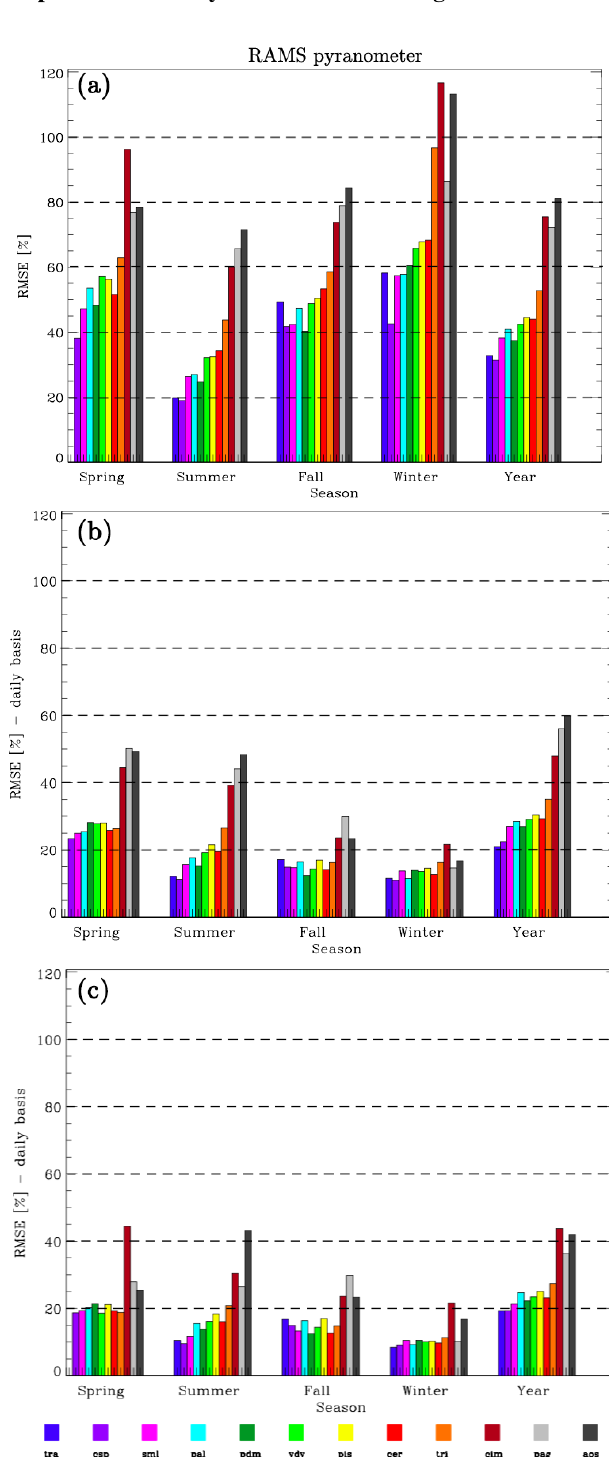
Figure 7. (a) rRMSE computed for different seasons and stations, as well as for the whole year, for the RAMS-GHI 1-day hourly fore- cast; (b) as in (a) for daily integrated GHI; (c) as in (b) after the MOS correction to the model